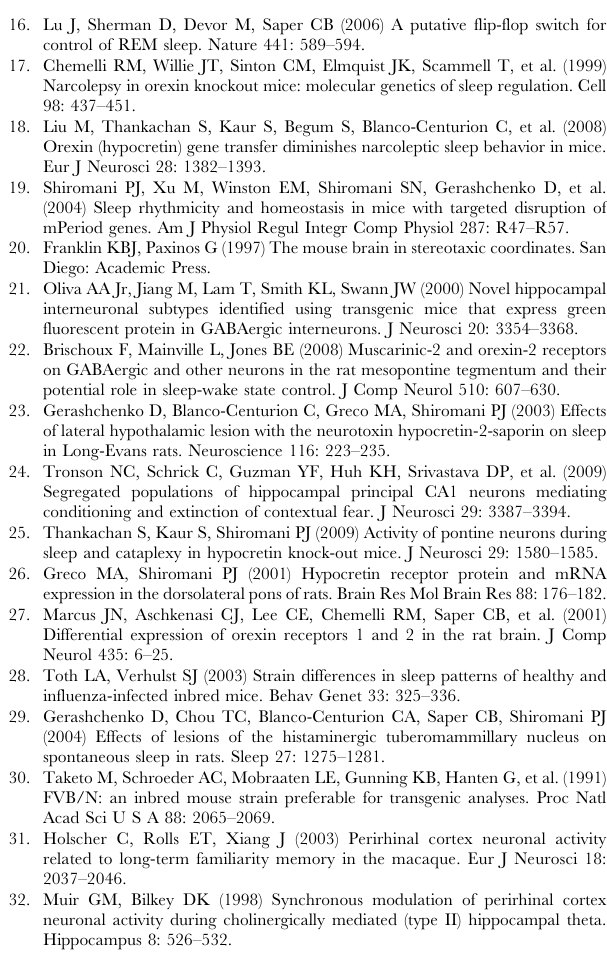
Figure S1 Effect of unconjugated saporin (SAP) on vlPAG neurons in a representative wildtype C57BL/6J mouse. Photo A depicts abundant NeuN labeled neurons surrounding the SAP microinjection site in the vlPAG. To verify that SAP was injected green fluorescent beads (2%) were added and photo B shows dispersal of beads at tip of injection site (photo B). Photo C is of a bead adjacent to the perikarya of a hypocretin-2 receptor bearing neuron (white arrow) indicating the ineffectiveness of unconjugat- ed SAP to kill neurons relative to the conjugated version. Photos A and B are of the same tissue section, and Photo C is from an adjacent tissue section that was processed for visualization of the HCRT-2